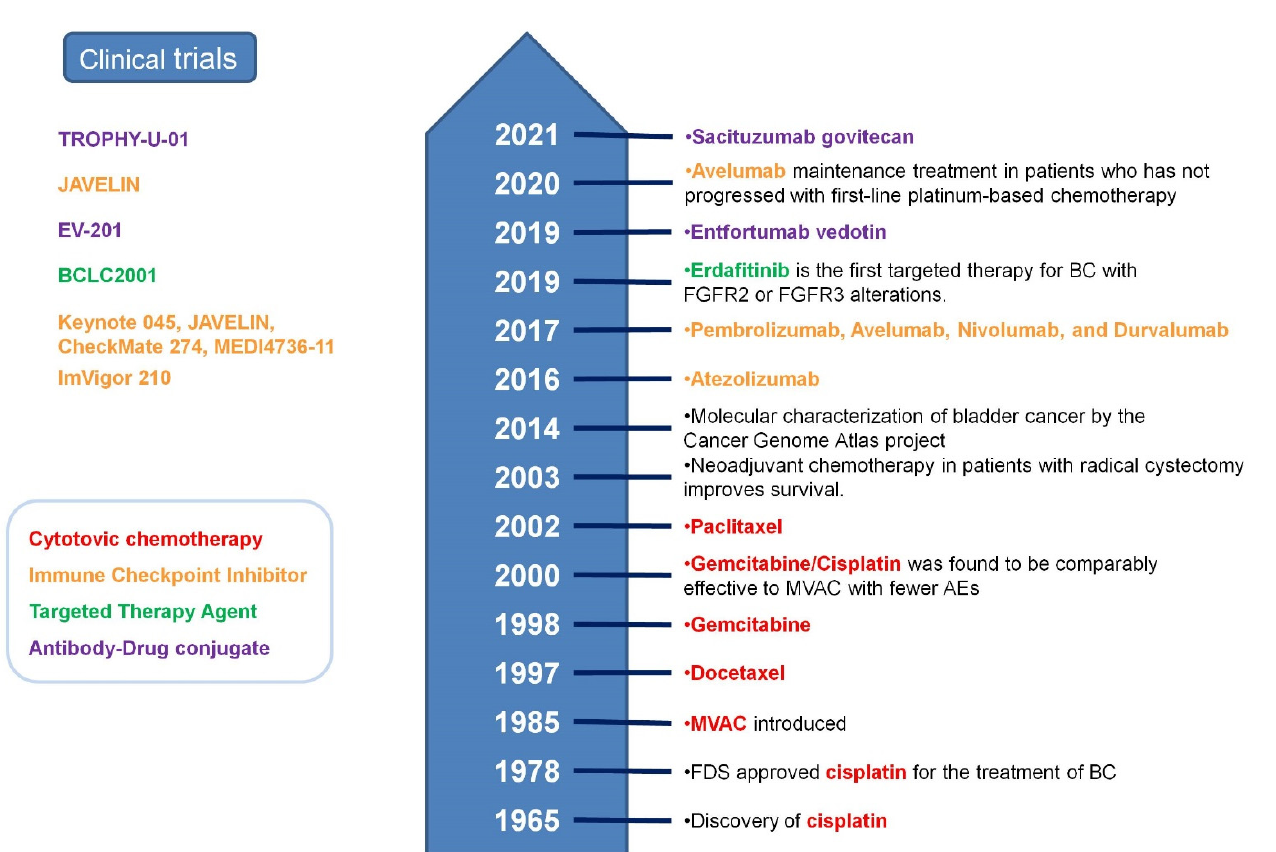
Figure 1. Timeline of BC clinical trials and FDA approval.